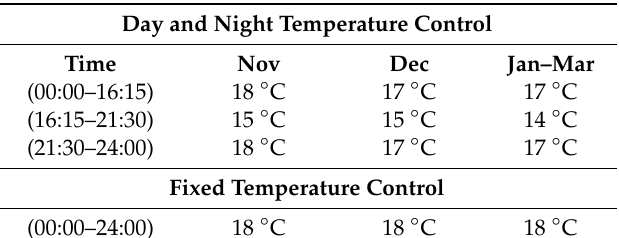
Table 7. Detail of temperature control used in Figure